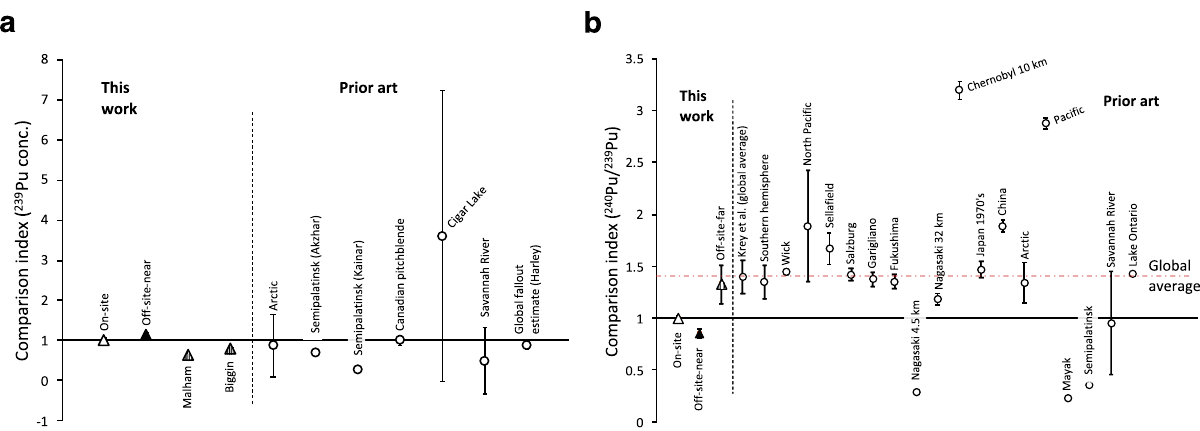
Fig. 4 Comparison indices. a 239 Pu concentration and b 240 Pu/ 239 Pu ratio, R 240/239 . Each comparison is annotated by location, as per, for 239 Pu concentration: Arctic 13 ; Semipalatinsk 37 ; Canadian pitchblende 2 ; Cigar Lake 8 ; Savannah River 12 and the global fallout estimate 4 . For R 240/239 : the global average 3 (also depicted by the broken red line); the Southern Hemisphere (Mozambique, South Africa, Central Chile and Southern Chile) 48 ; Wick 9 ; North Paci fi c 7 ; Sella fi eld, Salzburg and Garigliano 11 ; Fukushima and Nagasaki 40 ; Chernobyl 49 ; 1970 ’ s samples in Japan 50 ; China 51 ; Paci fi c 14 and Mayak 37 . Uncertainties derive from the original works or indicate the standard deviation of concentration indices for the larger sample sets (i.e., Cigar Lake, Nagasaki and Savannah